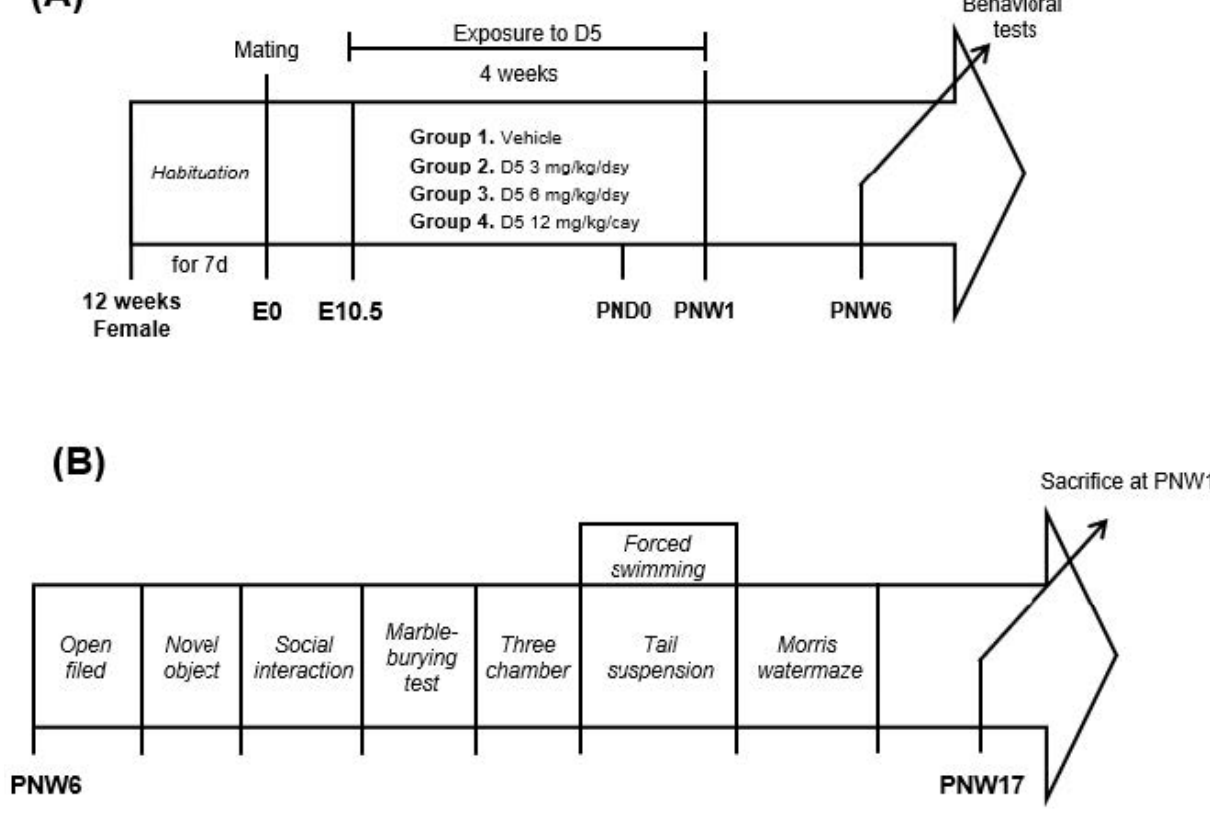
Figure 1. Experiment procedure: ( A ) maternal D5 exposure timetable; ( B ) behavioral test timetable.